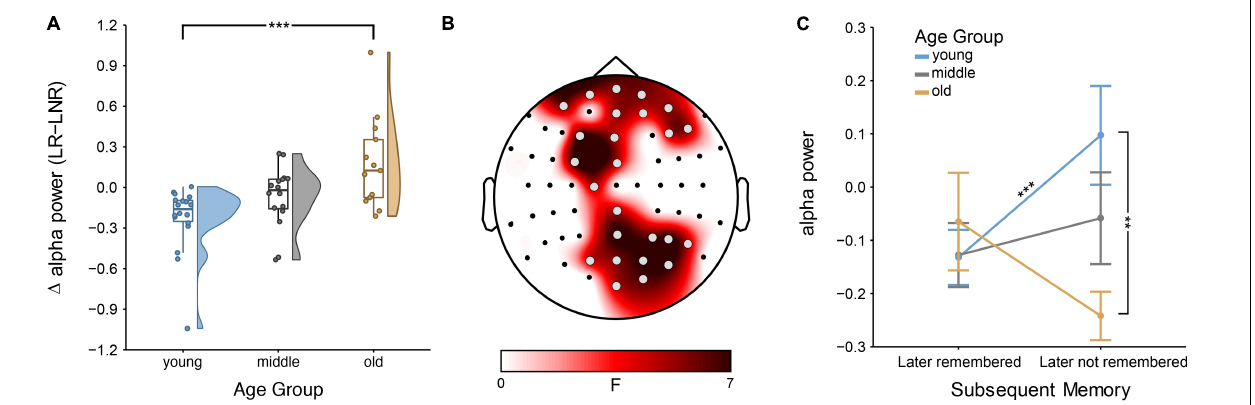
FIGURE 2 | Subsequent memory effect (SME) across age groups: (A) Encoding-related power decreases in younger adults [i.e., lower power for later-remembered (LR) than for later-not-remembered (LNR) sentences], averaged across all significant electrodes (shown in B ) within the lower alpha band (i.e., individual alpha peak frequency (IAF) – 2 Hz to IAF) are attenuated in middle-aged adults and turn into a power increases in older adults; error bars reflect one standard error; ∗∗∗ p < 0.001 (B) Scalp topography shows that the age difference in the SME within the lower alpha band is distributed across bilateral frontal and right-hemispheric